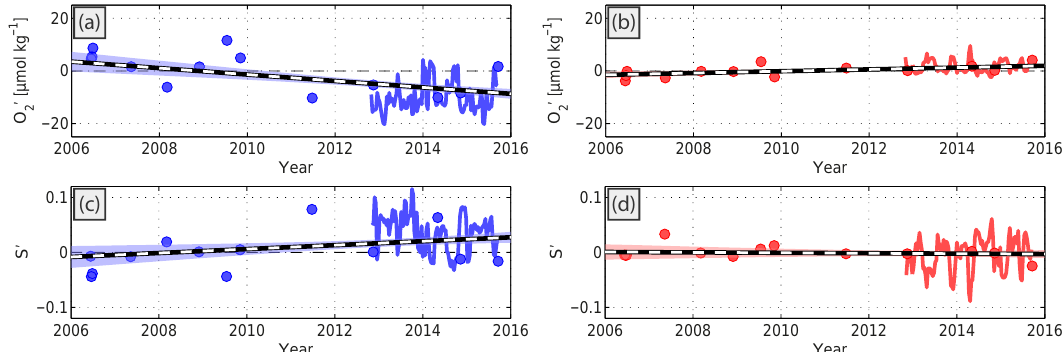
Figure 3. Oxygen ( a and b ) and salinity ( c and d ) anomaly time series from moored observations (solid line) at 11 ◦ N, 21 ◦ W and shipboard observations (dots) at 11 ◦ N, 23 ◦ W. Panels (a) and (c) show averages between 200 and 400m. Panels (b) and (d) show averages between 500 and 800m. Black dashed lines show respective trends from combined moored and shipboard observations: